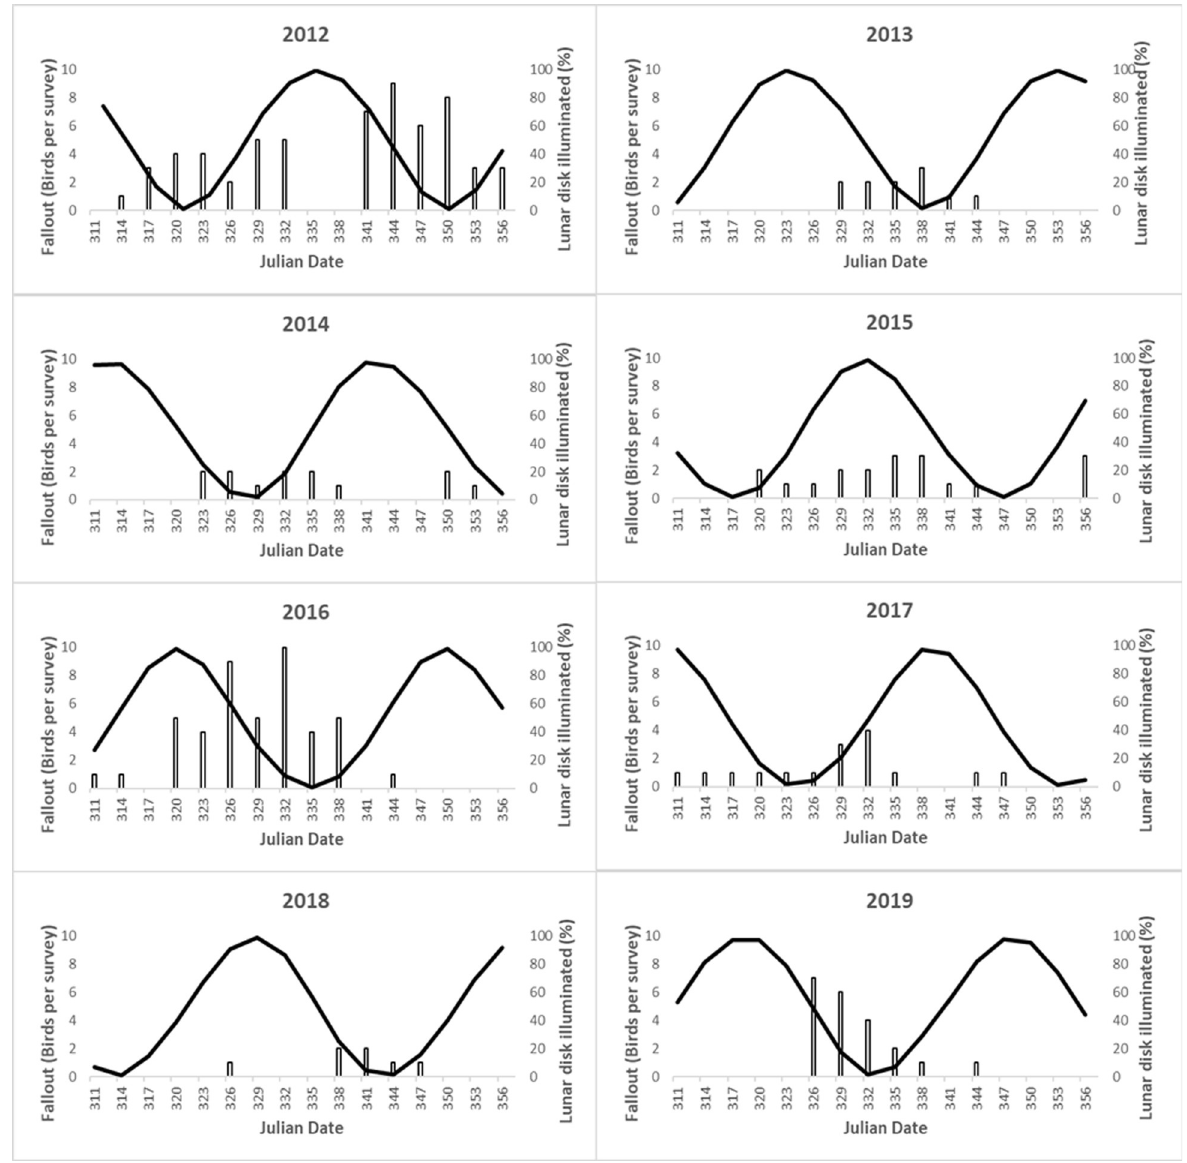
Fig 5. Moon illumination and fallout. Time series of the number of grounded WTSH observed per survey (bars) and nightly lunar illumination (back line). The dates on the x-axis indicate the survey days.